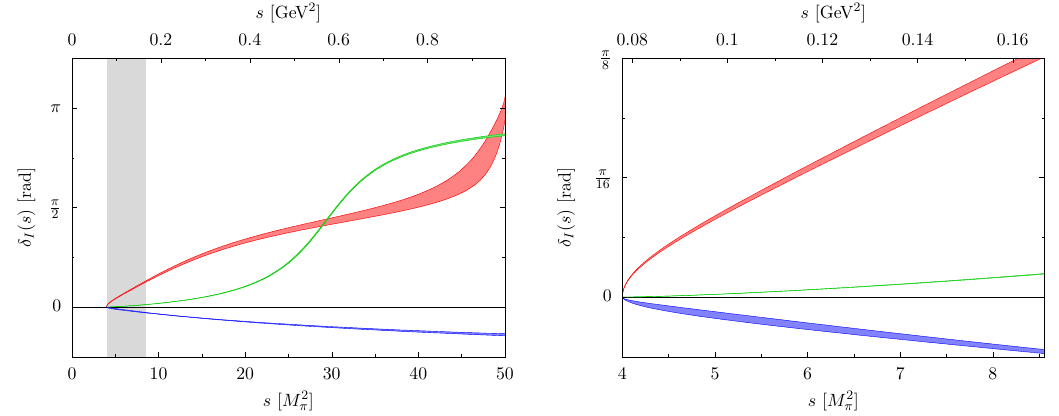
Figure 1 . The S - and P -wave ππ scattering phase shifts δ 0 (red), δ 1 (green), and δ 2 (blue) covering low-energy uncertainty bands as determined by Roy equation analysis [69, 70]. Left panel: behavior of the phase shifts in the low-energy region below the K ¯ K -threshold at about 50 M 2 space for η → 3 π is indicated by the gray region. Right panel: magnification of the physical decay